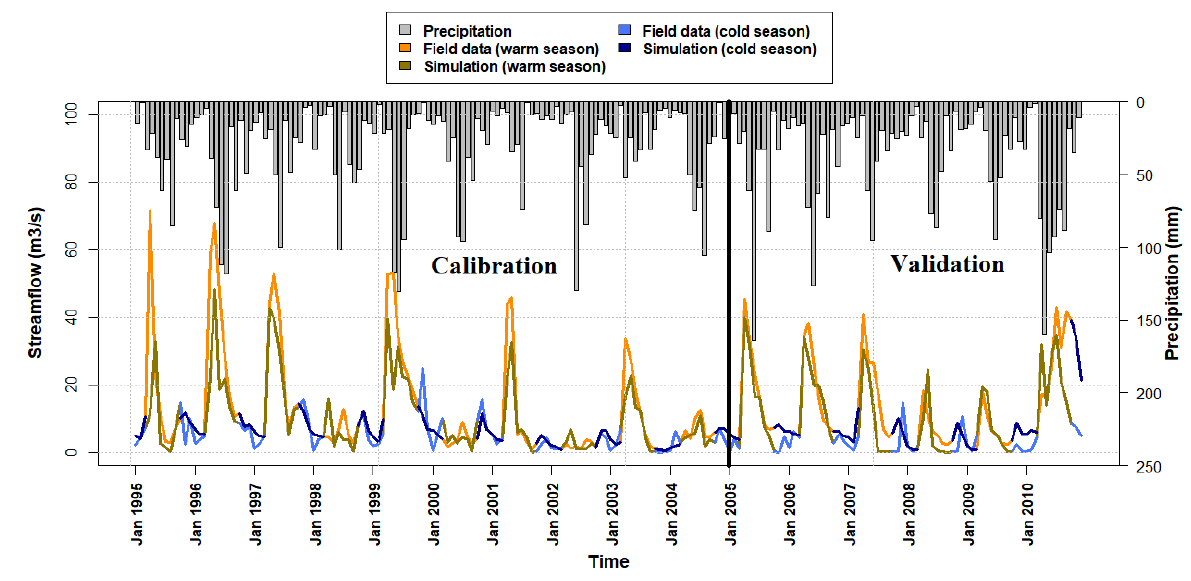
Figure 3. Simulated and observed stream flows and precipitation.